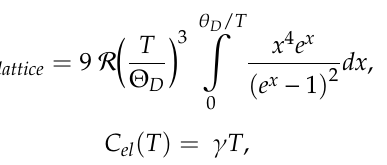
Table 1. Critical temperatures of the heat capacity anomalies [31] and crystallographic parameters of the Er x Dy 1 − x Al 2 compounds with x = 0.45, 0.67, and 0.90. T * is the temperature of the second anomaly observed in the heat capacity data.